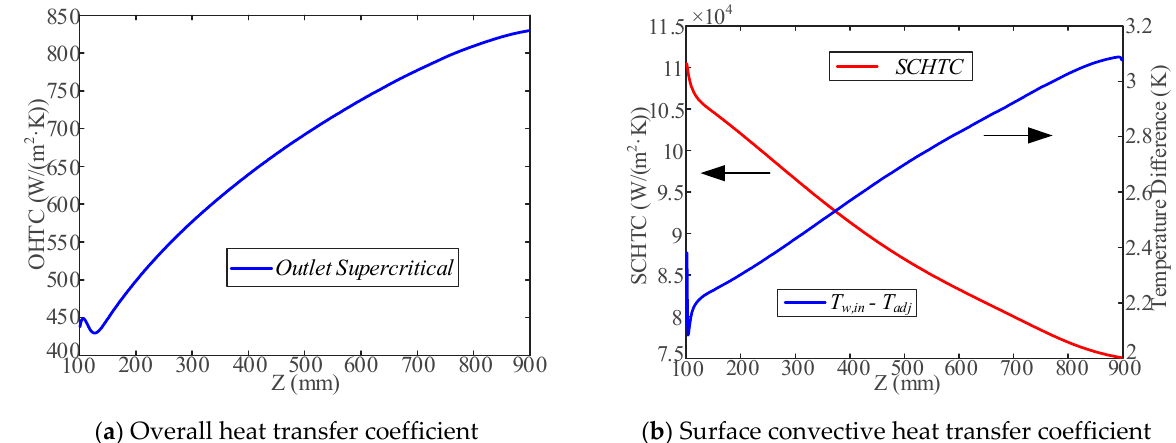
Figure 5. Distribution of the OHTC and SCHTC along the channel.